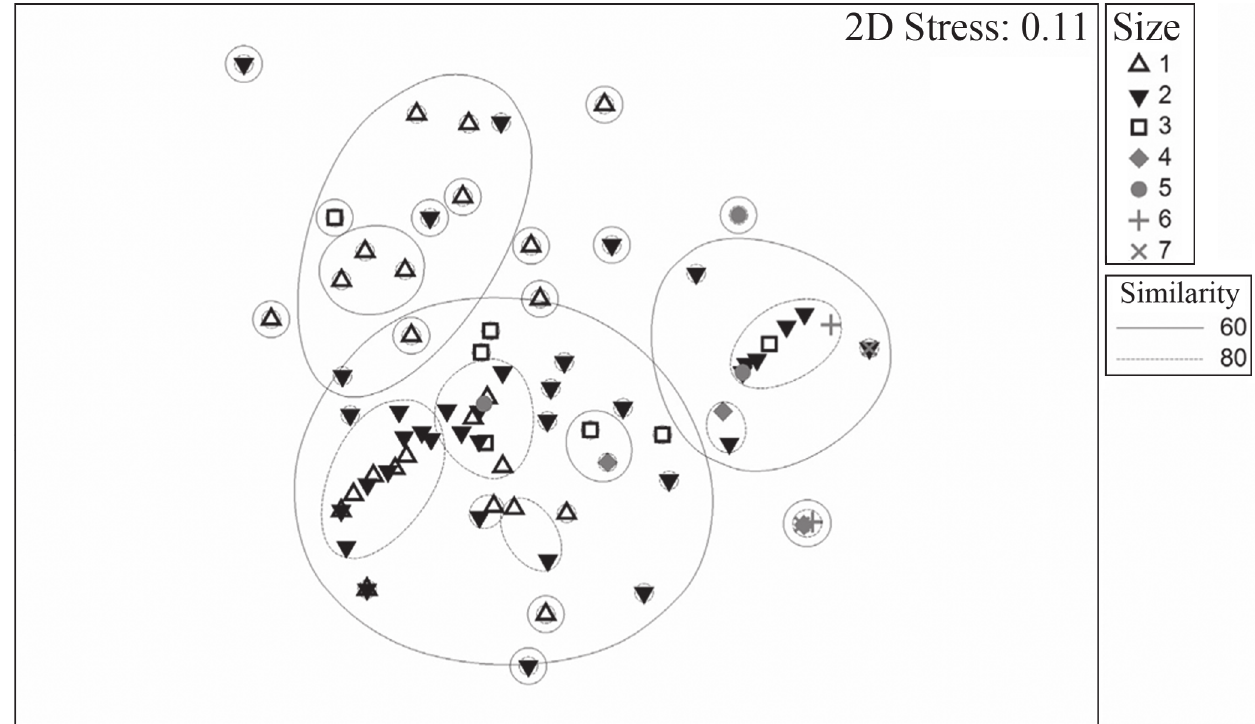
Fig. 2. Ordination resulting from Non-metric Multi-dimensional Scaling analyses (NMDS) with cluster overlay (volume prey) among sizes classes of Lutjanus analis from Abrolhos Bank coral reefs, Eastern Brazil, between June 2005 and March 2007.